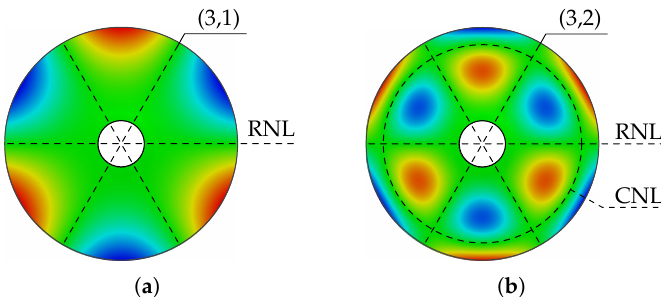
Figure 1. Illustration of the description rule for mode shapes of discs on two examples; mode shape (3,1) with only radial node lines ( a ) and (3,2) with radial and circular node lines ( b